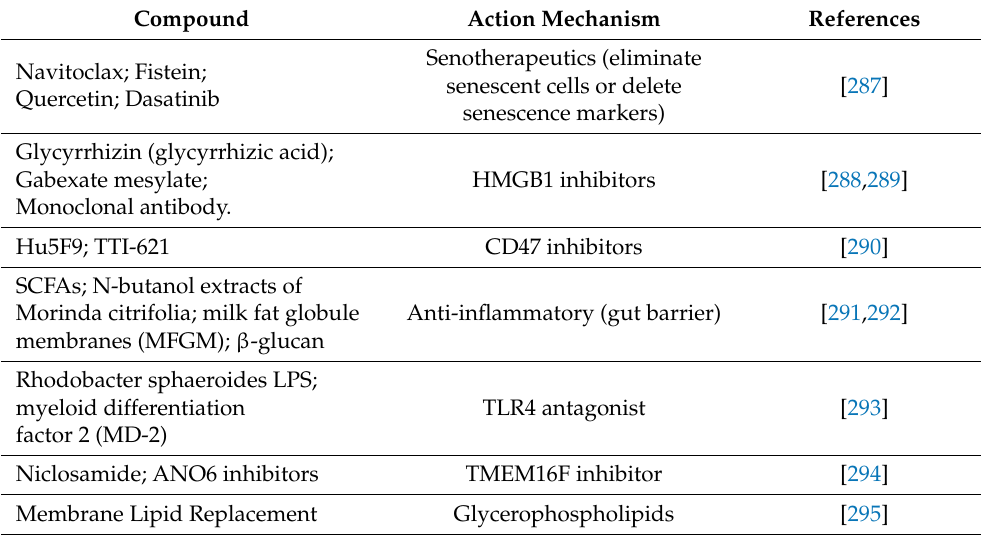
Table 2. Quick reminder of gut barrier restoration